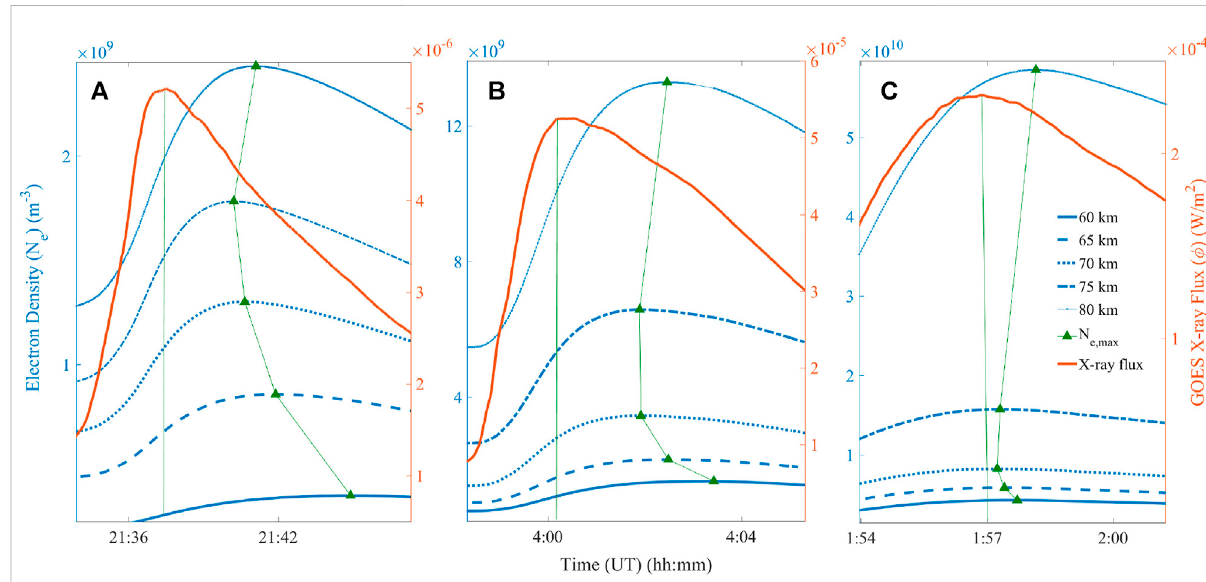
FIGURE 1 Temporal pro fi les of solar x-ray fl ux ( ϕ ( t )) during (A) C5.2, (B) M5.2 and (C) X2.2 classes of fl ares and corresponding D-region electron density ( N e ( t )) as computed from Eq. 2 at different altitudes over N60. The t ϕ